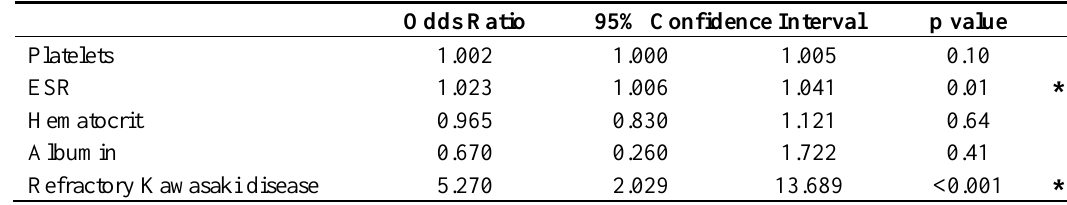
Table 2. Results of multivariate binary regression analysis. Odds ratio favors coronary artery involvement. Abbreviations: ESR, erythrocyte sedimentation rate ( * p value ≤ 0.05 was considered statistically